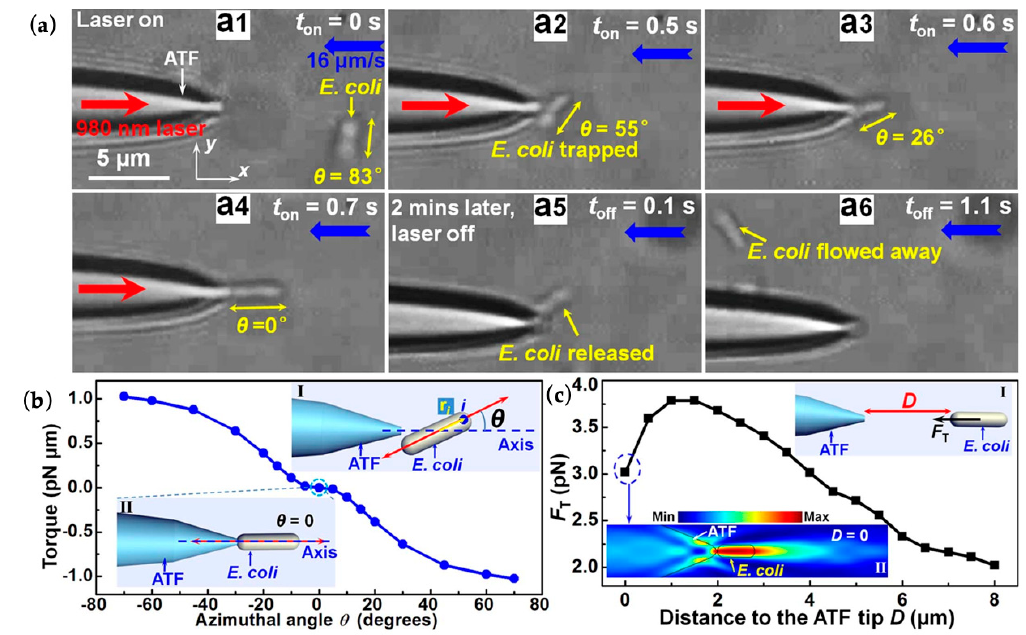
Figure 11. Optical trapping of a single E. coli cell [64]. ( a ) Optical microscope images of the trapping and orientation process of a single E. coli cell. The blue, red, and yellow arrows indicate flow velocity (16 mm / s), the input laser with an optical power of 30 mW, and the orientation of the E. coli , respectively. ( b ) The calculated torque acting on an E. coli cell as a function of azimuthal angle. ( c ) Calculated trapping force ( F T ) exerted on a single E. coli cell as a function of distance ( D ) between the cell and the fiber tip.